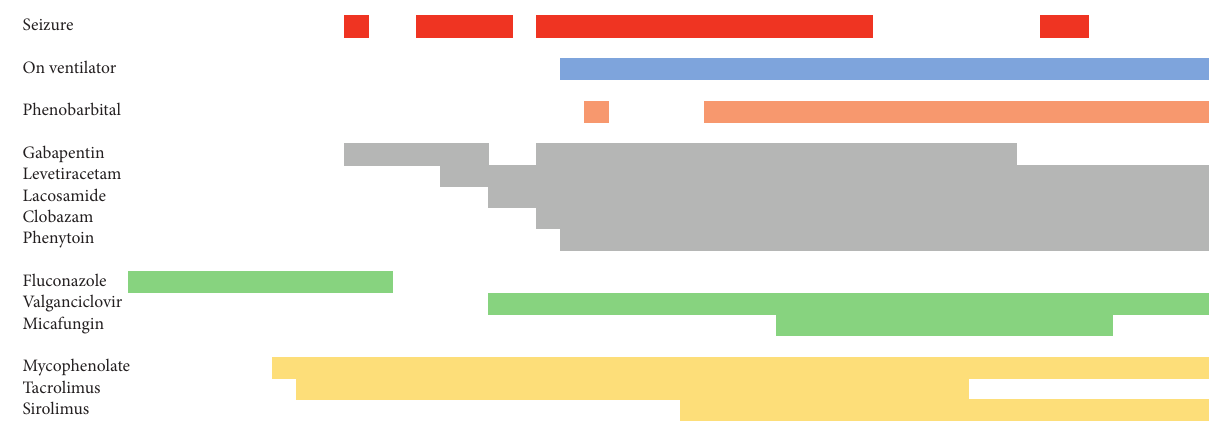
Figure 1: Timeline of seizures, medications, and ventilator